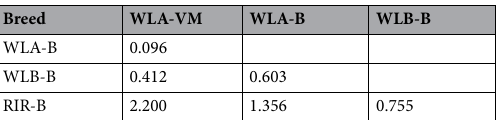
Table 2. Matrix of the genetic distances among the four groups. The code letters correspond to the group as follows: WLA-VM represents the VM of the White Leghorn stock A; WLA-B represents the blood of the